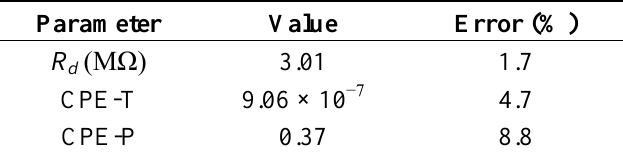
Table 1. Results of fitting presented in the Figure 5.